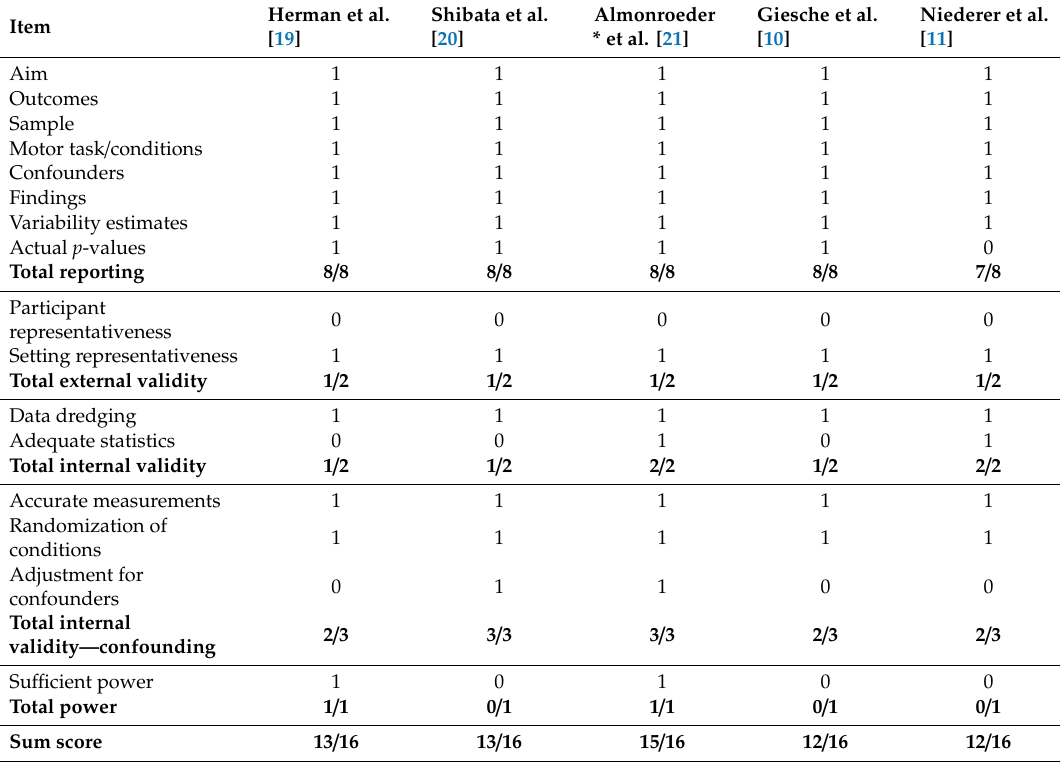
Table 3. Study quality (adapted Black and Down